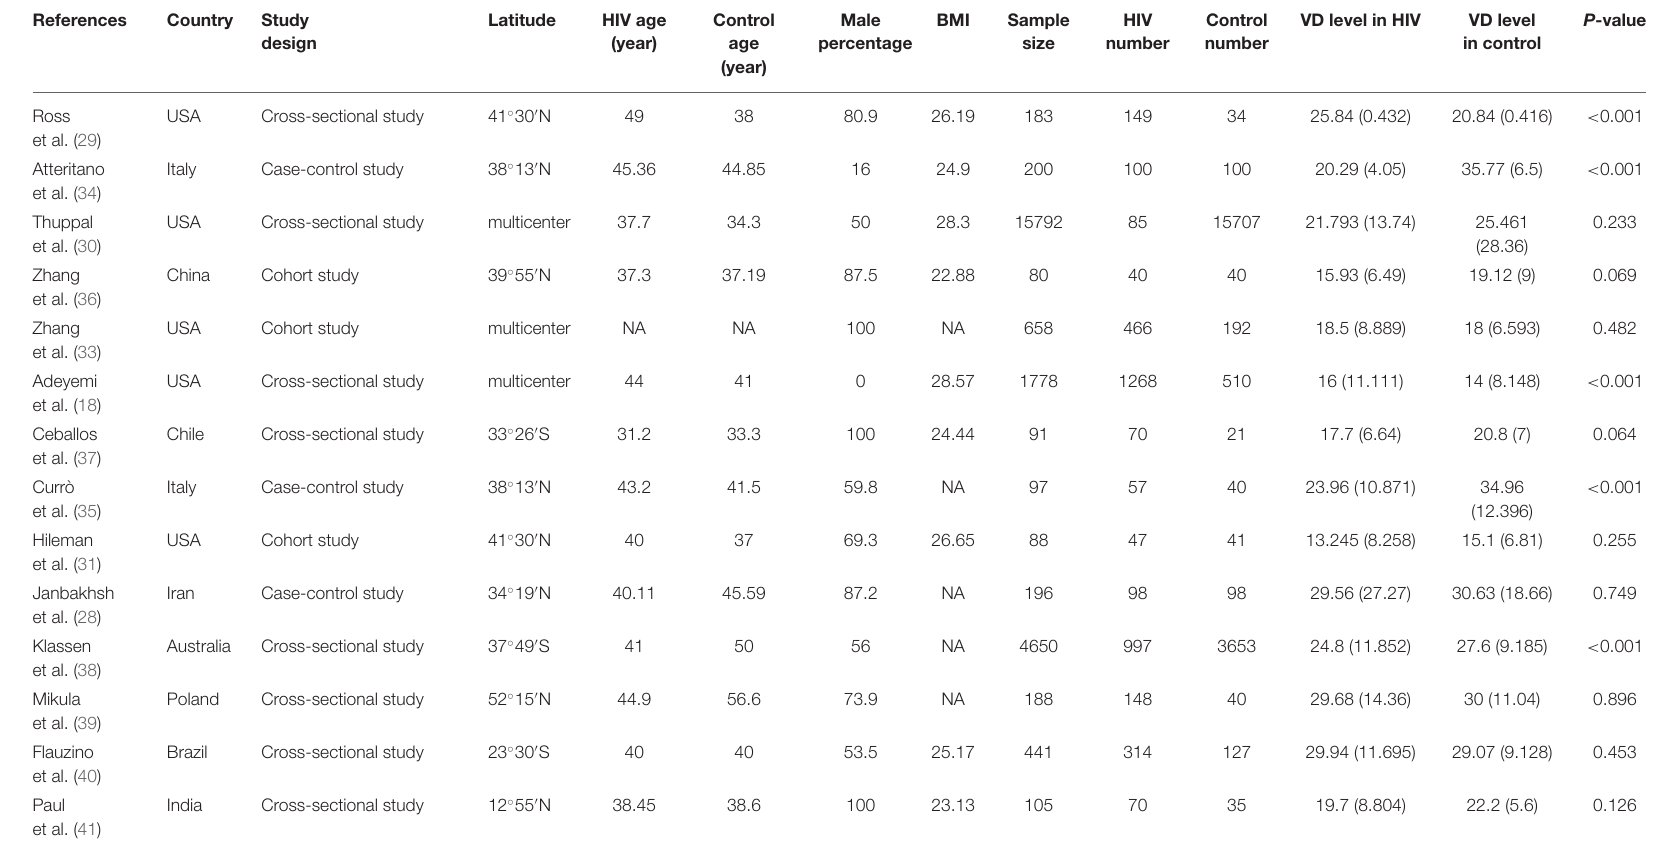
TABLE 1 | The characteristics of included studies for assessing vitamin D